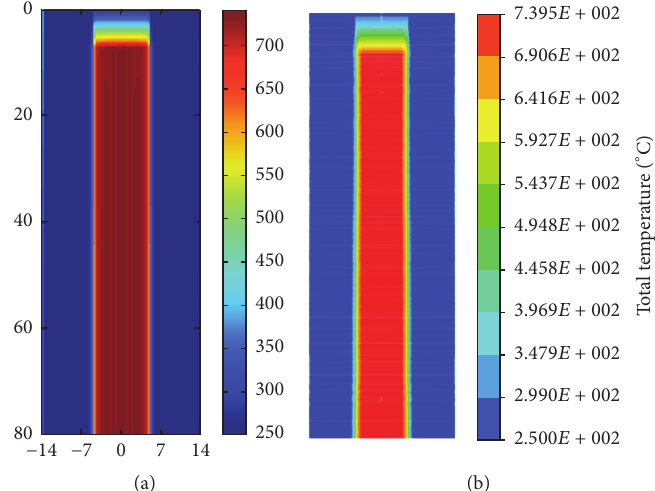
Figure 9: Temperature field of the target area (neglecting the axial heat transfer). ((a) is calculated by the new code and (b) is calculated by Fluent.)